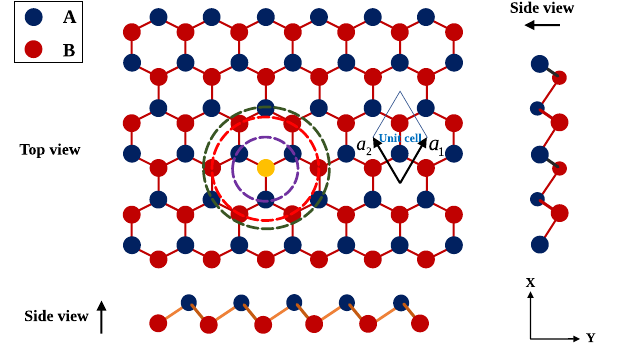
Figure 1. Crystal structure of Germanene.